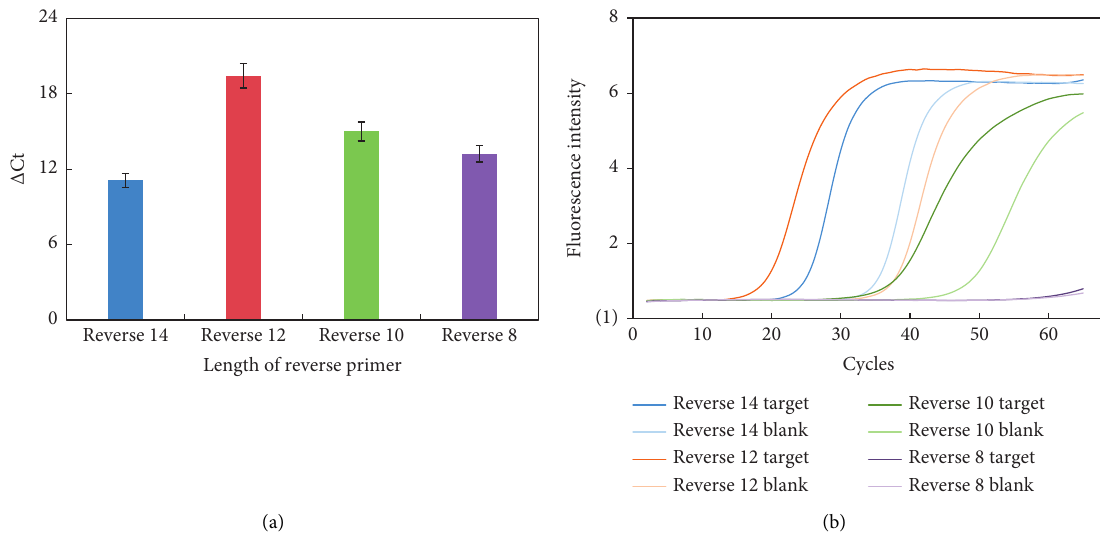
Figure 1: The △ Ct value (a) and fluorescence intensities (b) vs different lengths of reverse primer. Experiment conditions: miRNA was 1nM; forward primer was 4 μ M; reverse primer was 2 μ M; and mediator template was 50 nM; Tm was 42 ° C. The detection procedure was carried out as described in the experiment section.